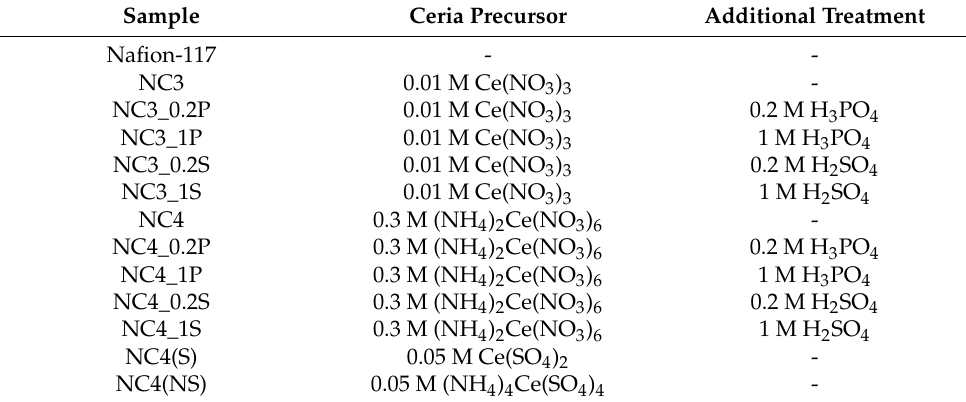
Table 1. Manufactured hybrid